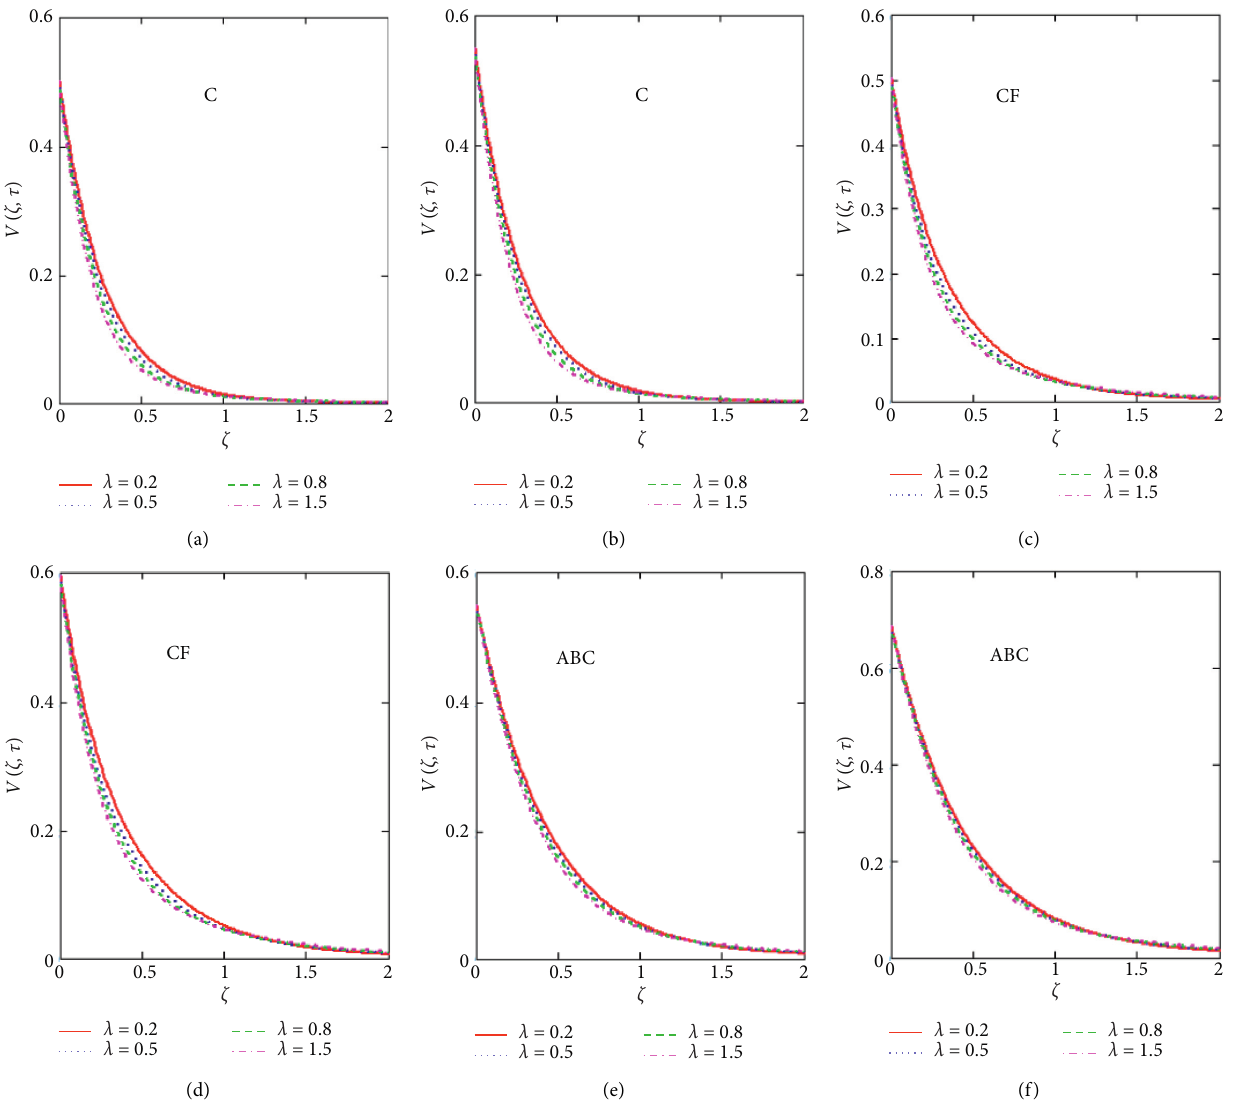
Figure 6: Plot via C, CF, and AB approaches for velocity with different values of λ